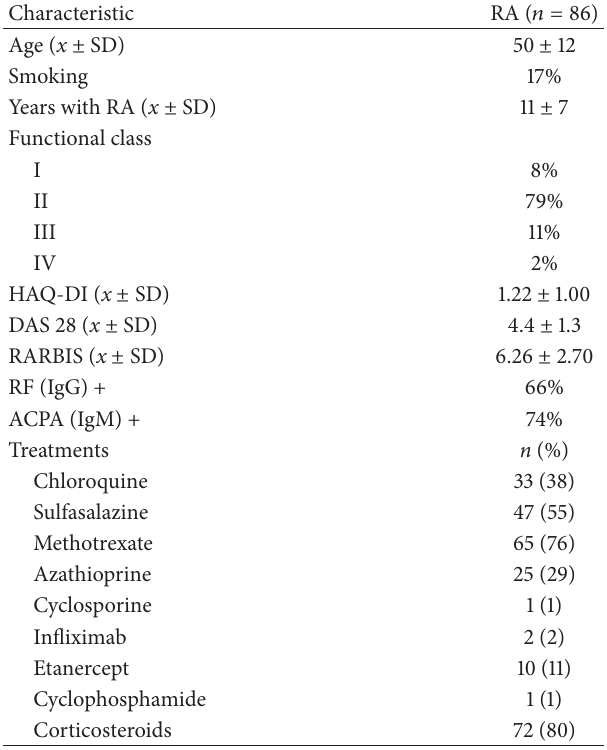
Table 2: Demographic and clinical characteristics of RA